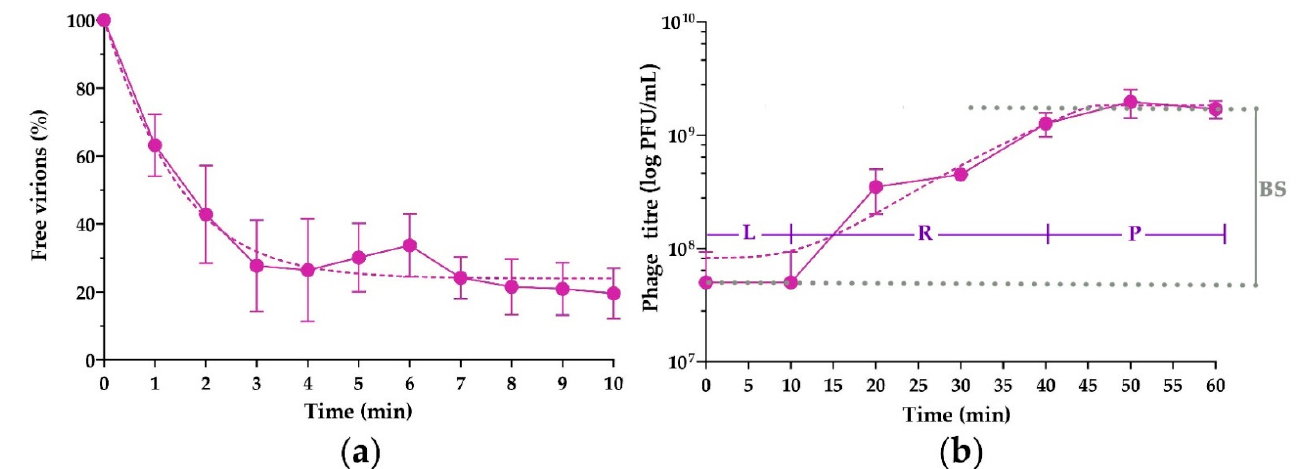
Figure 5. Infection parameters of Pseudomonas phage Pf-10. ( a ) Adsorption assay ( b ) One-step growth curve. L, latent phase; R, virion release phase; P, plateau phase; BS, burst size. The graphs were created with GraphPad Prism 8.4.3. Values in panels ( a ) and ( b ) represent the mean of five and three independent trials, respectively, and error bars represent the standard deviation.